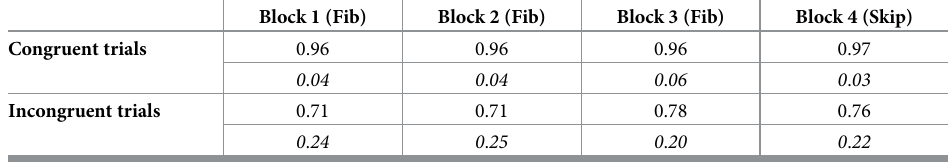
Table 2. Mean ( Standard Deviation ) accuracy in each condition for each block for congruent and incongruent tri- als (Analysis 1).